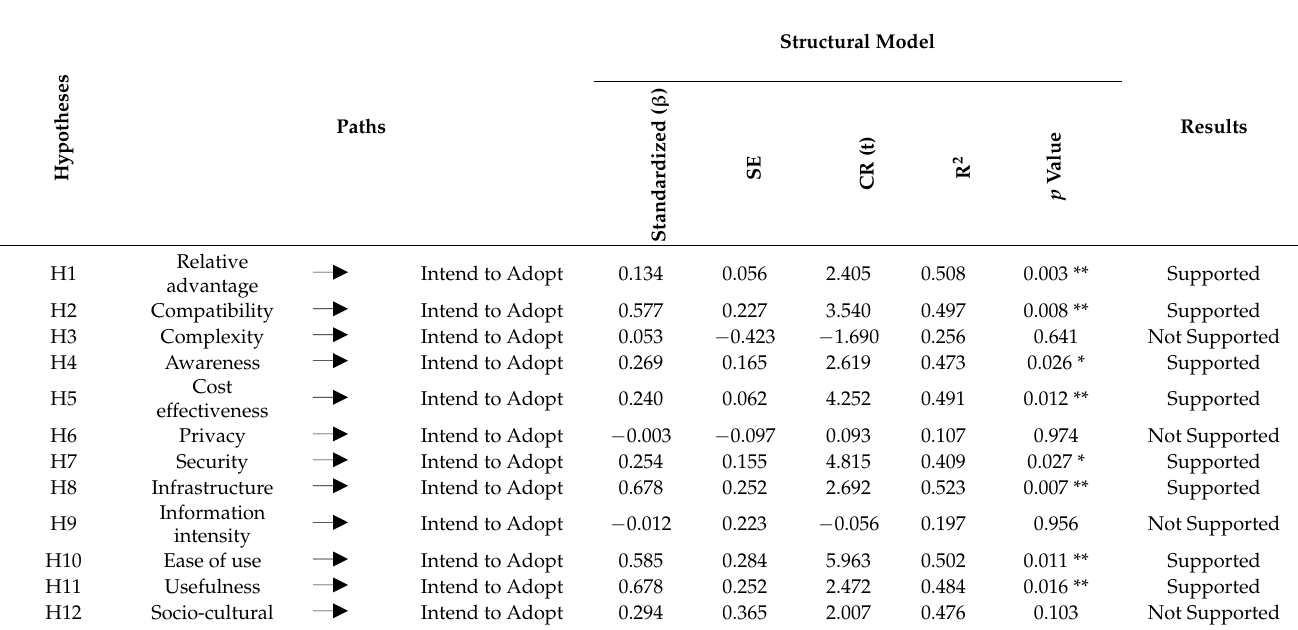
Table 4. Results of the hypothesized path relationships.